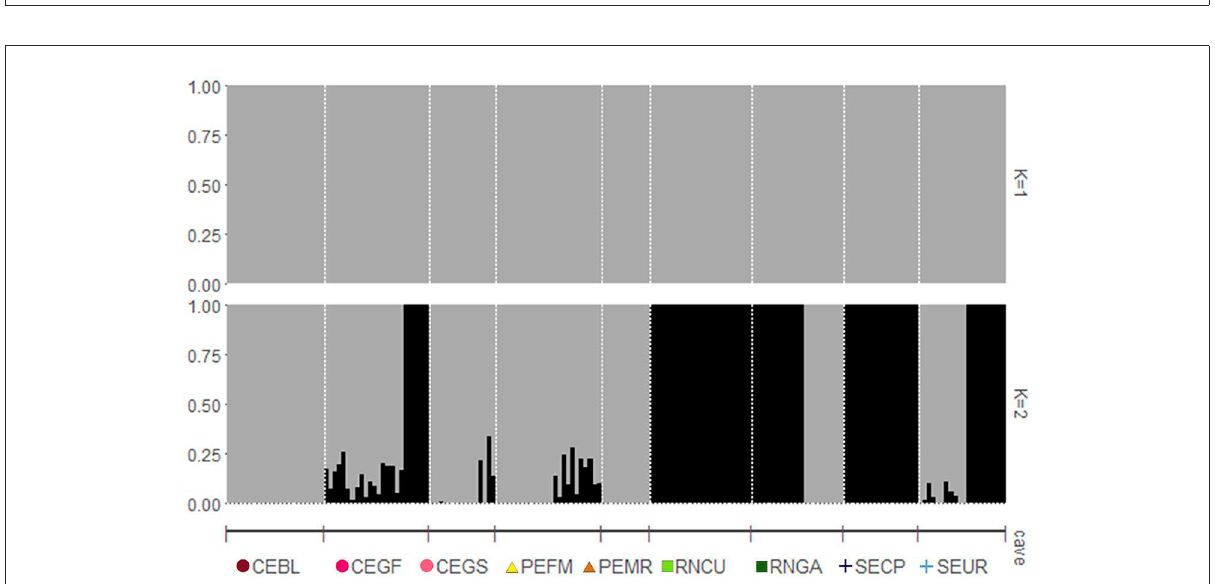
FIGURE2 An ADMIXTURE analysis shows the proportion of ancestry for P. gymnonotus from nine bat caves in northeastern Brazil. Each vertical bar represents an individual, ordered by cave. Vertical bars with both colors indicate individuals of mixed ancestry. Plots represent individuals from one ancestral population ( K = 1; at the top) and two ancestral populations ( K = 2; at the bottom). For complete cave names, please see Table 1.